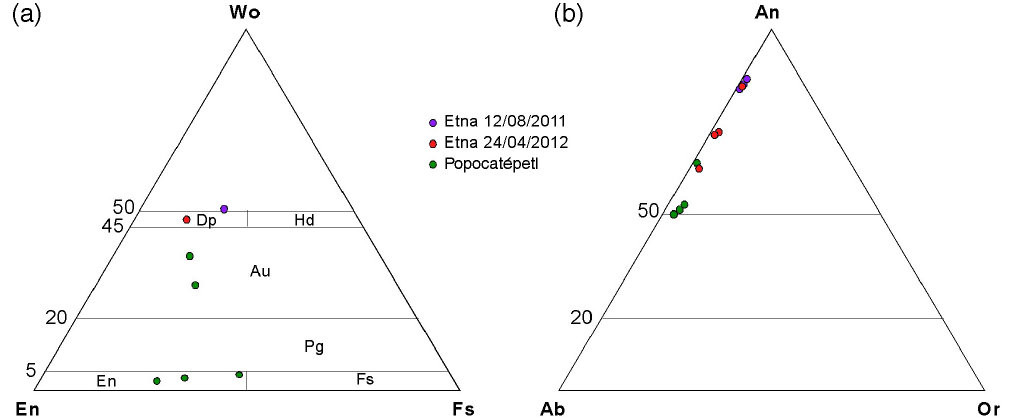
Figure 3. Ternary diagrams for the classification of (a) pyroxenes and (b)